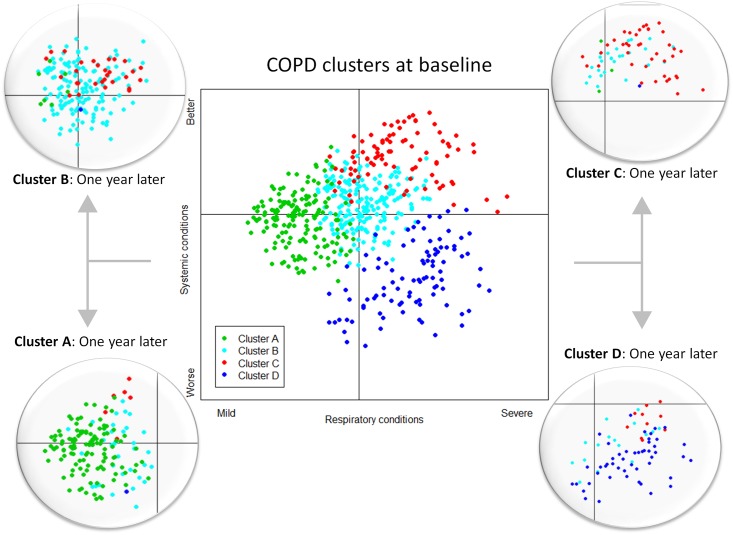
Map of clusters and distribution of patients.Map created by the first and second components derived from the MCA is shown at the center. Four circles at the sides show how patients move between clusters after one year of follow-up. Relative positions of the subjects in the planes are represented by different colors, depending on the subtype provided by the cluster analysis. Definition of the axes is suggested based on information provided in appendix Table A1. The horizontal axis, first component, can be defined as an index of the respiratory conditions of the patient, milder (left side) vs. more severe (right side). The vertical axis, second component, can be defined as an index of the systemic status, worse (bottom) vs. better (top).